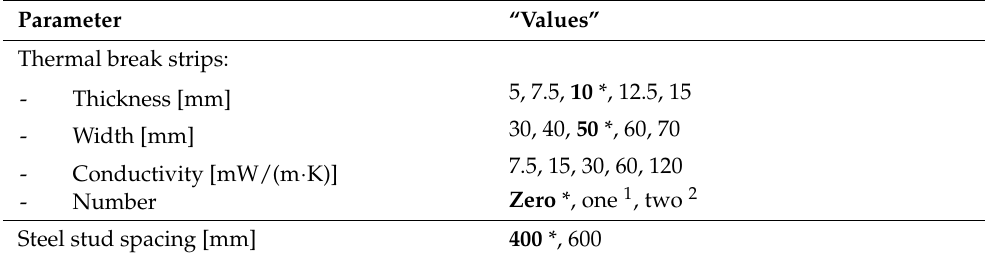
Table 1. Parameters to be evaluated and assigned values.